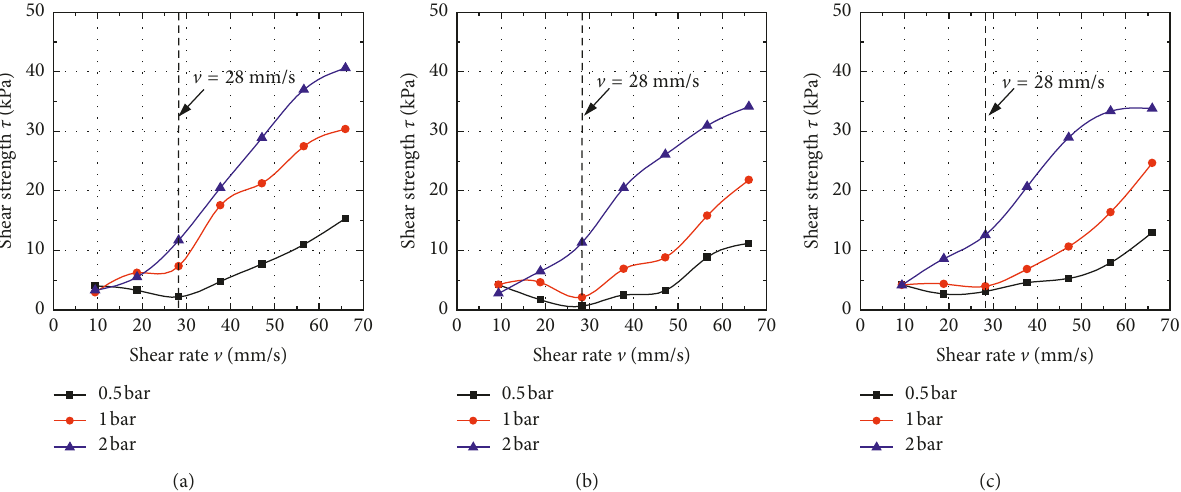
Figure 11: Effect of shear rate of the test device on the shear strength of the conditioned sand with different liquid conditioners injected: (a) bentonite slurry 20%; (b) HPMC 15%; (c) CMC 15%.